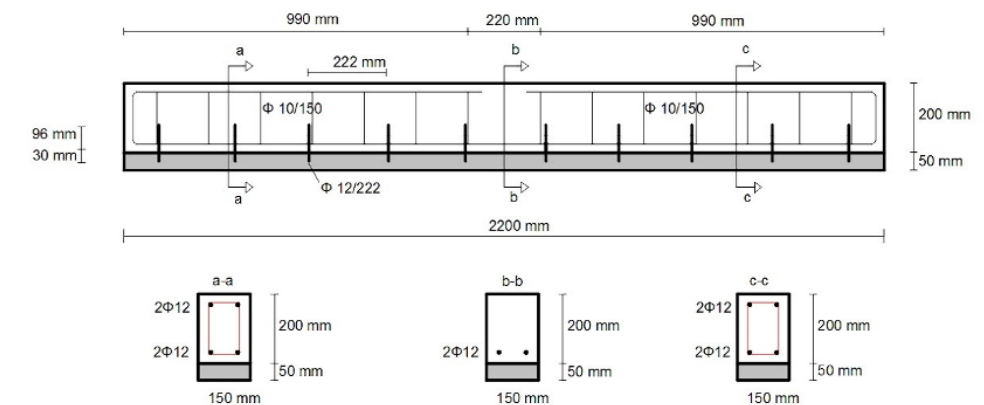
Figure 2. Strengthened beams using dowels.